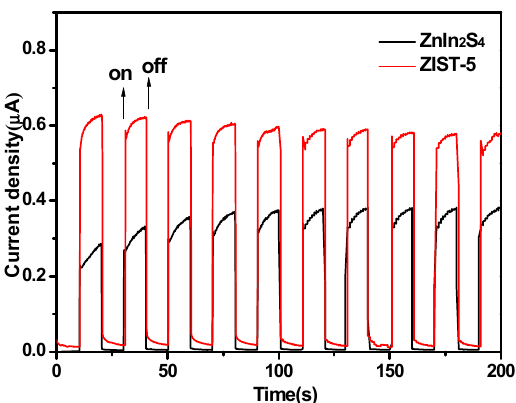
Figure 15. PL spectra of ZnIn 2 S 4 and ZIST-5.